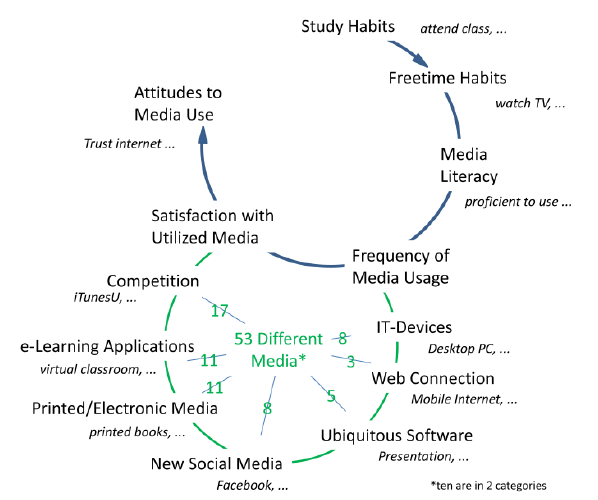
Figure 2. Schematic image of the survey’s main groups of